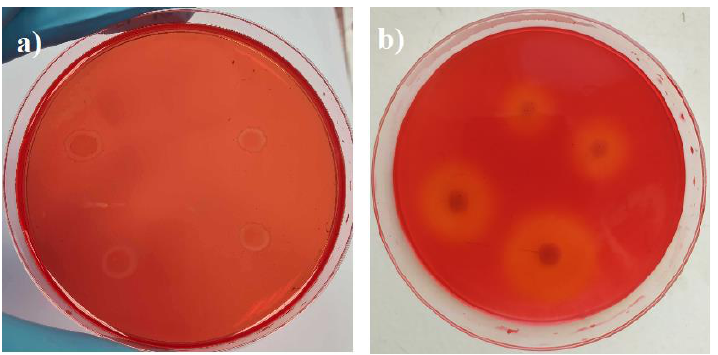
Figure 2. Visual assessment of cellulase activity in CMC medium by flooding Petri dishes with Congo red: ( a ) P. putida after growing for 13 days; ( b ) Rh. oryzae after growing for 12 days.